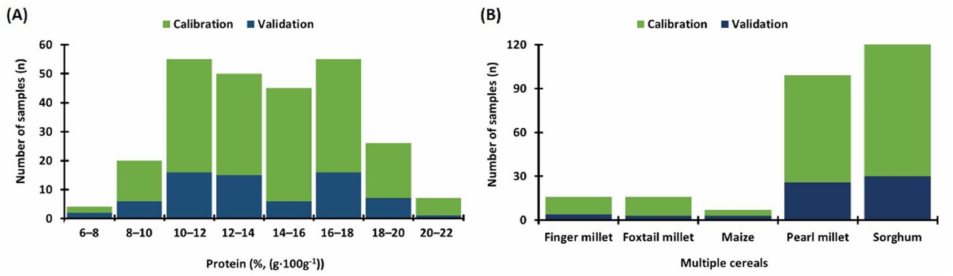
Figure 2. Box plots depicting variation and distribution of protein content (%, (g · 100 g − 1 )) in the grains of five cereals, as estimated through laboratory analyses. Legend: Each box represents one crop species; different crops are distinguished by color (finger millet = brown; maize = yellow; sorghum = green; foxtail millet = orange; pearl millet = grey; and the entire set of 328 multiple cereals = blue); solid line within the box (–) represents the mean of each crop.